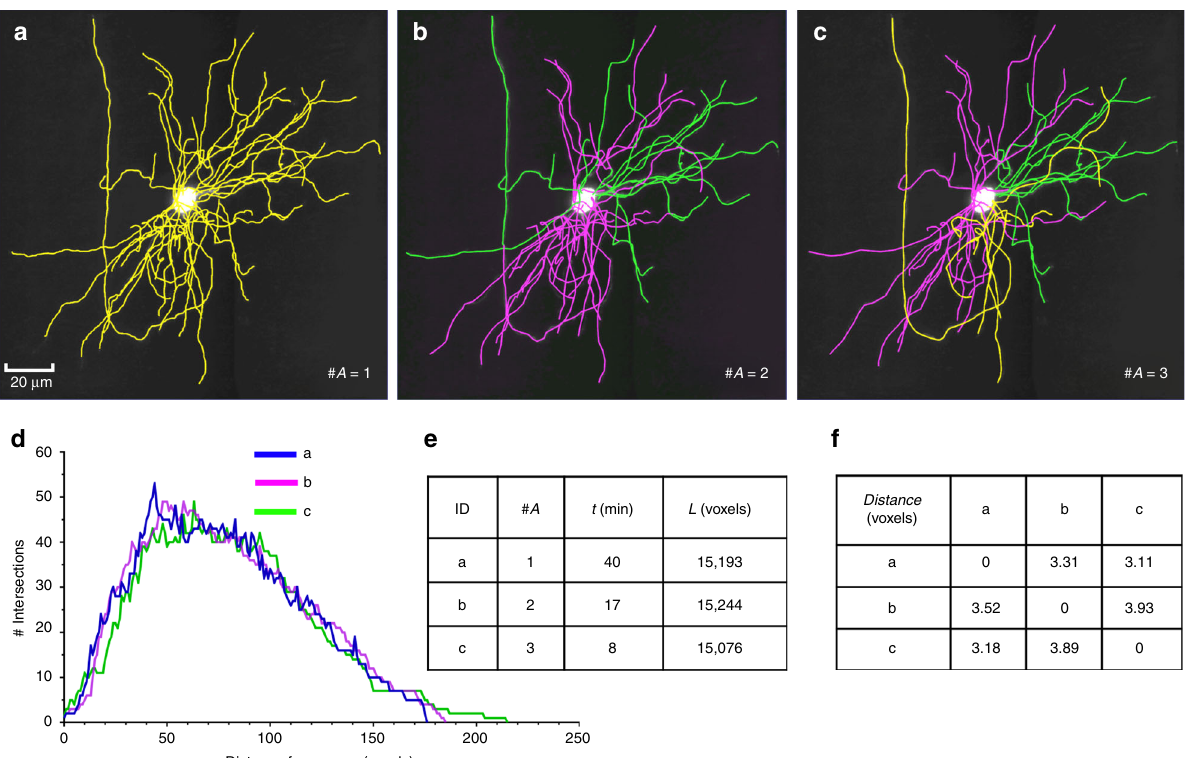
Fig. 5 Results produced using the collaboration mode of TeraVR. a – c Reconstructions done by different numbers of collaborating annotators; different colors of neurites indicate parts done by different annotators; #A: number of annotators. d Sholl analysis of three reconstructions in a – c . e Summary of the number of annotators, reconstruction time, and the total length of reconstructions in a – c . f The pairwise spatial distance of reconstructions in a –